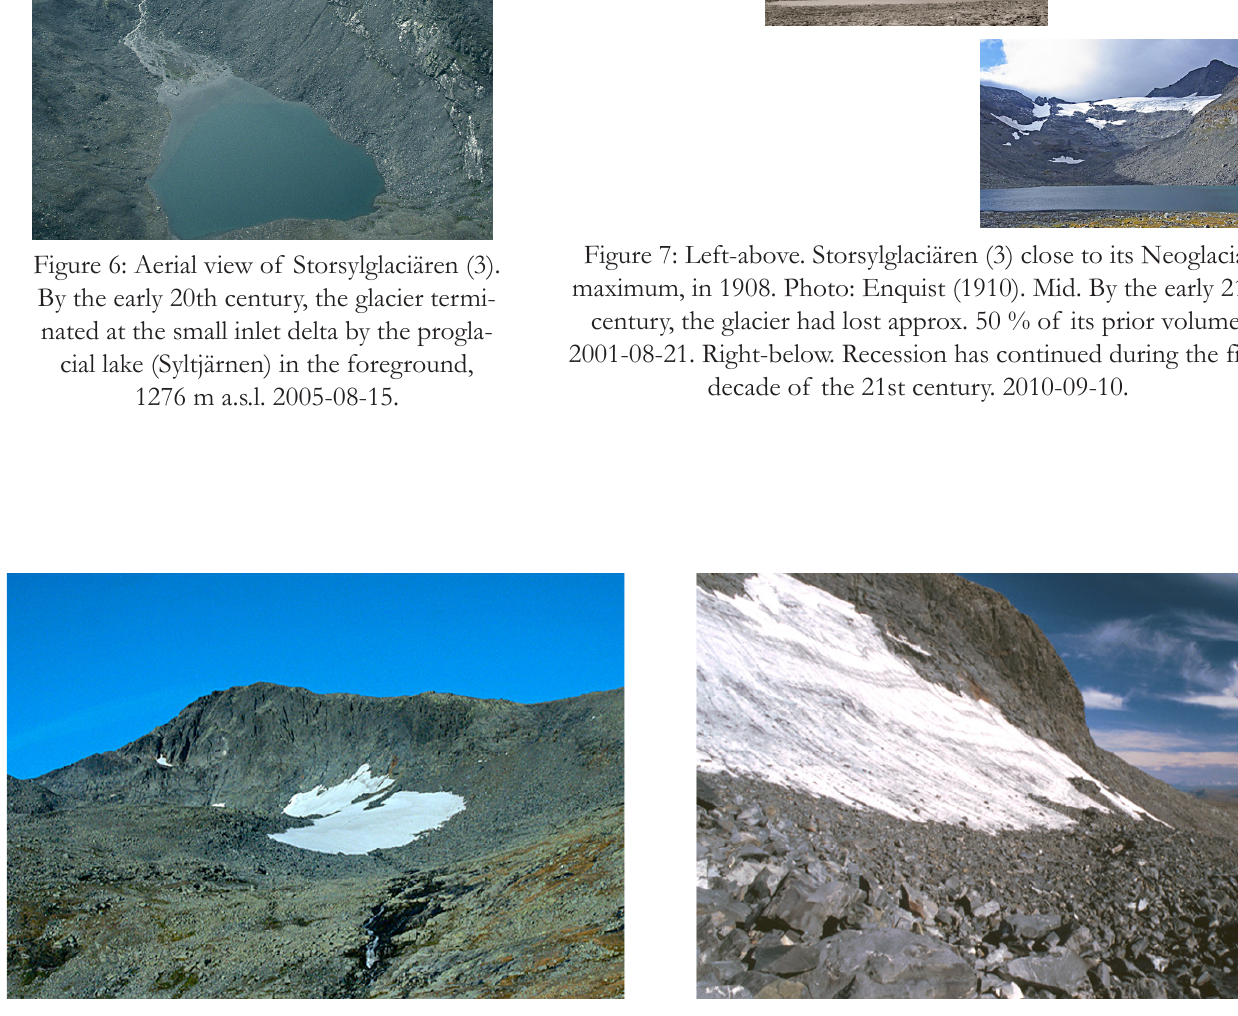
Figure 8: Left. Lillsylen (4) from the east. 2009-09-15. Right. The lower front of the ice patch (1500 m a.s.l.) and the frin- ging protalus rampart.